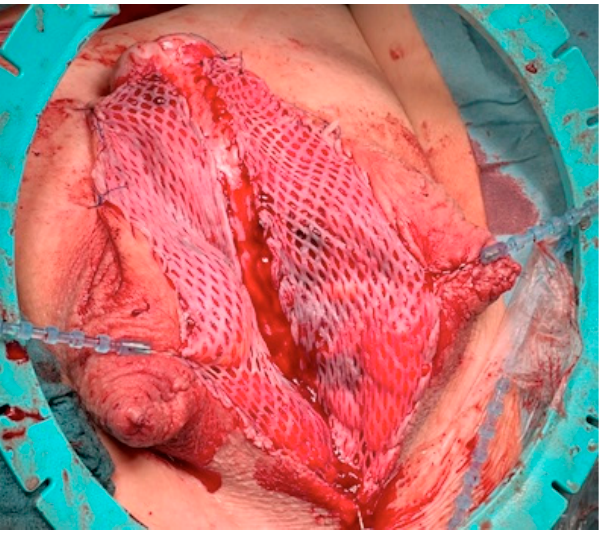
Figure 5. The mesh transplant is sutured between the incised urethral stricture and the skin edge.